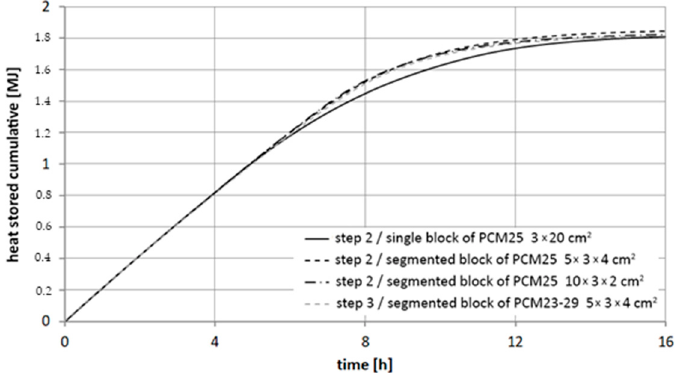
Figure 15. Total amount of accumulated heat stored inside the PCM block.